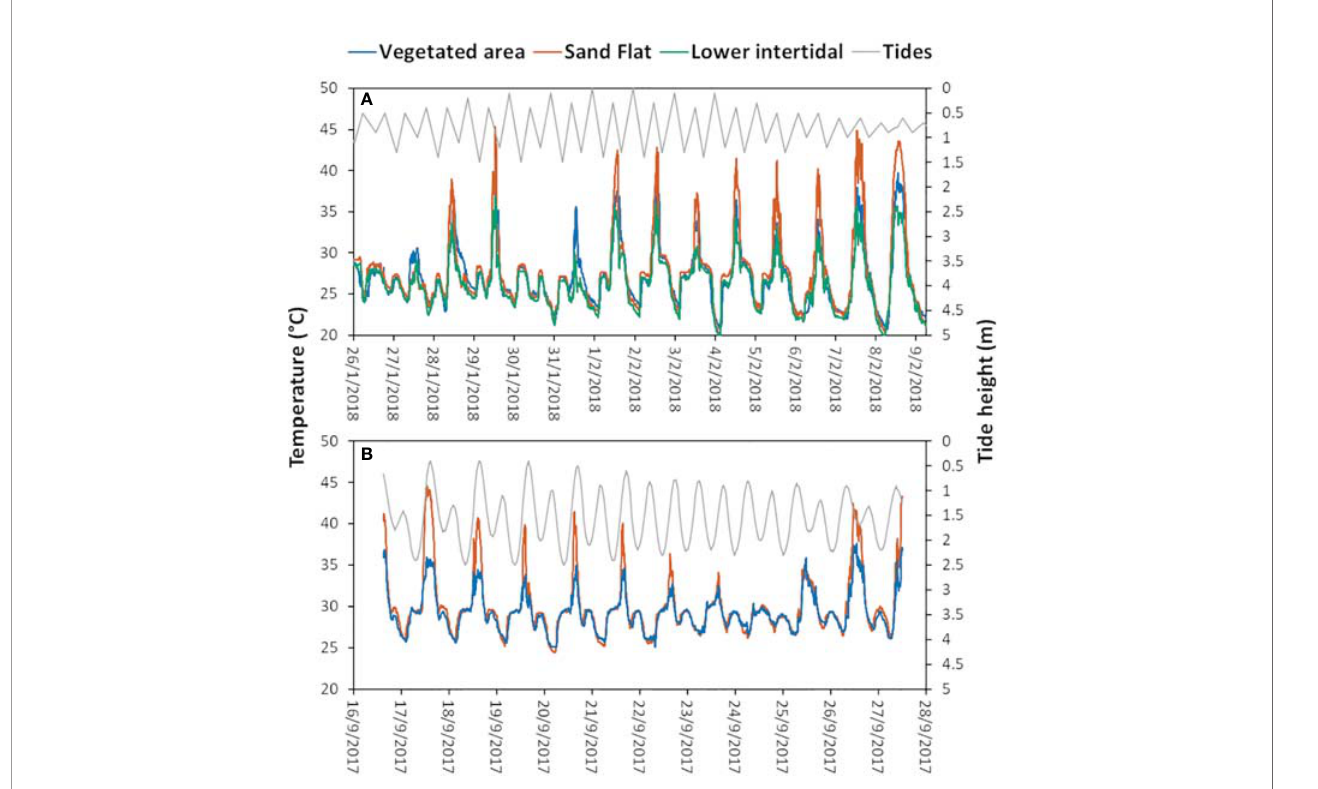
phylogeny on cardiac function and metabolic rate patterns, the data were treated as independent and phylogeny was not accounted for in further analyses.